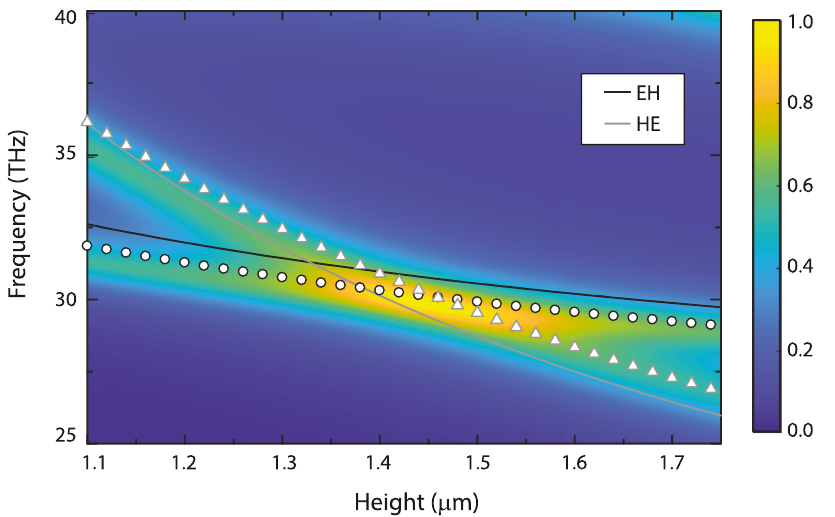
Figure 3: Dependence of the modes supported by an all-dielectric metamaterial as a function of height and frequency. The color plot shows the absorptivity, the open symbols are from Eigenvalue simulations, and the solid curves are from the theory presented in Eqs. (2)–(5). Black mode, and gray colors for HE colors are for the EH 111 111